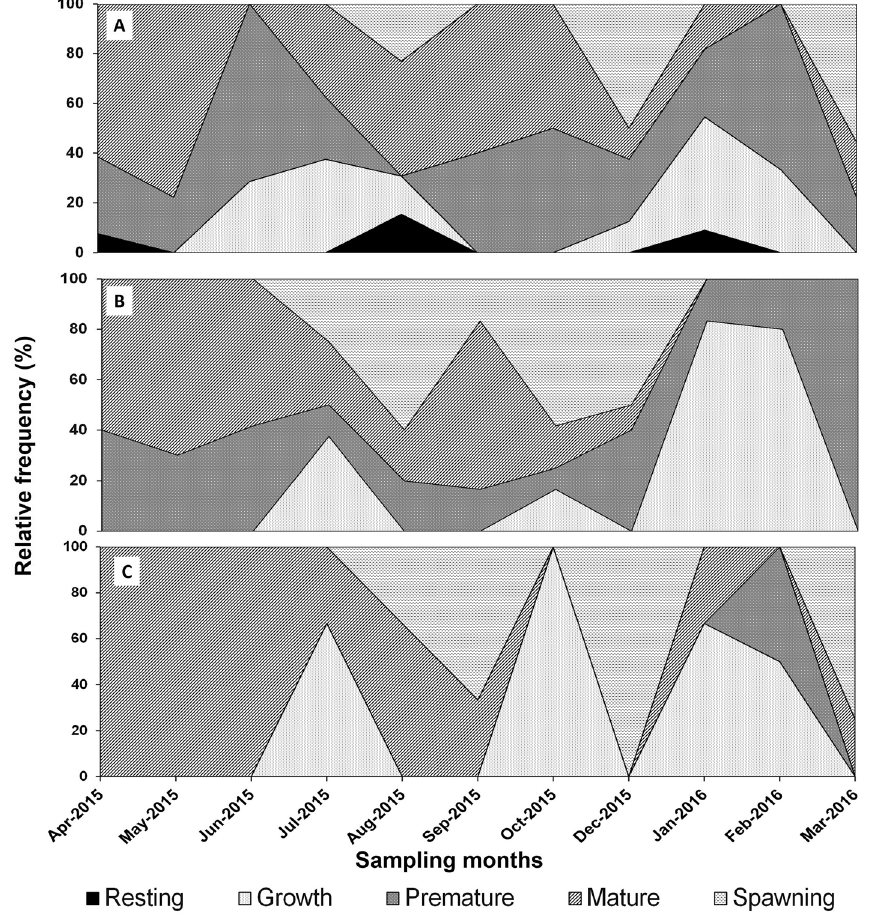
Figure 4. Relative frequencies of the reproductive stages of Topxopneustes roseus throughout the sampling period, ( A ) females, ( B ) males, and ( C )